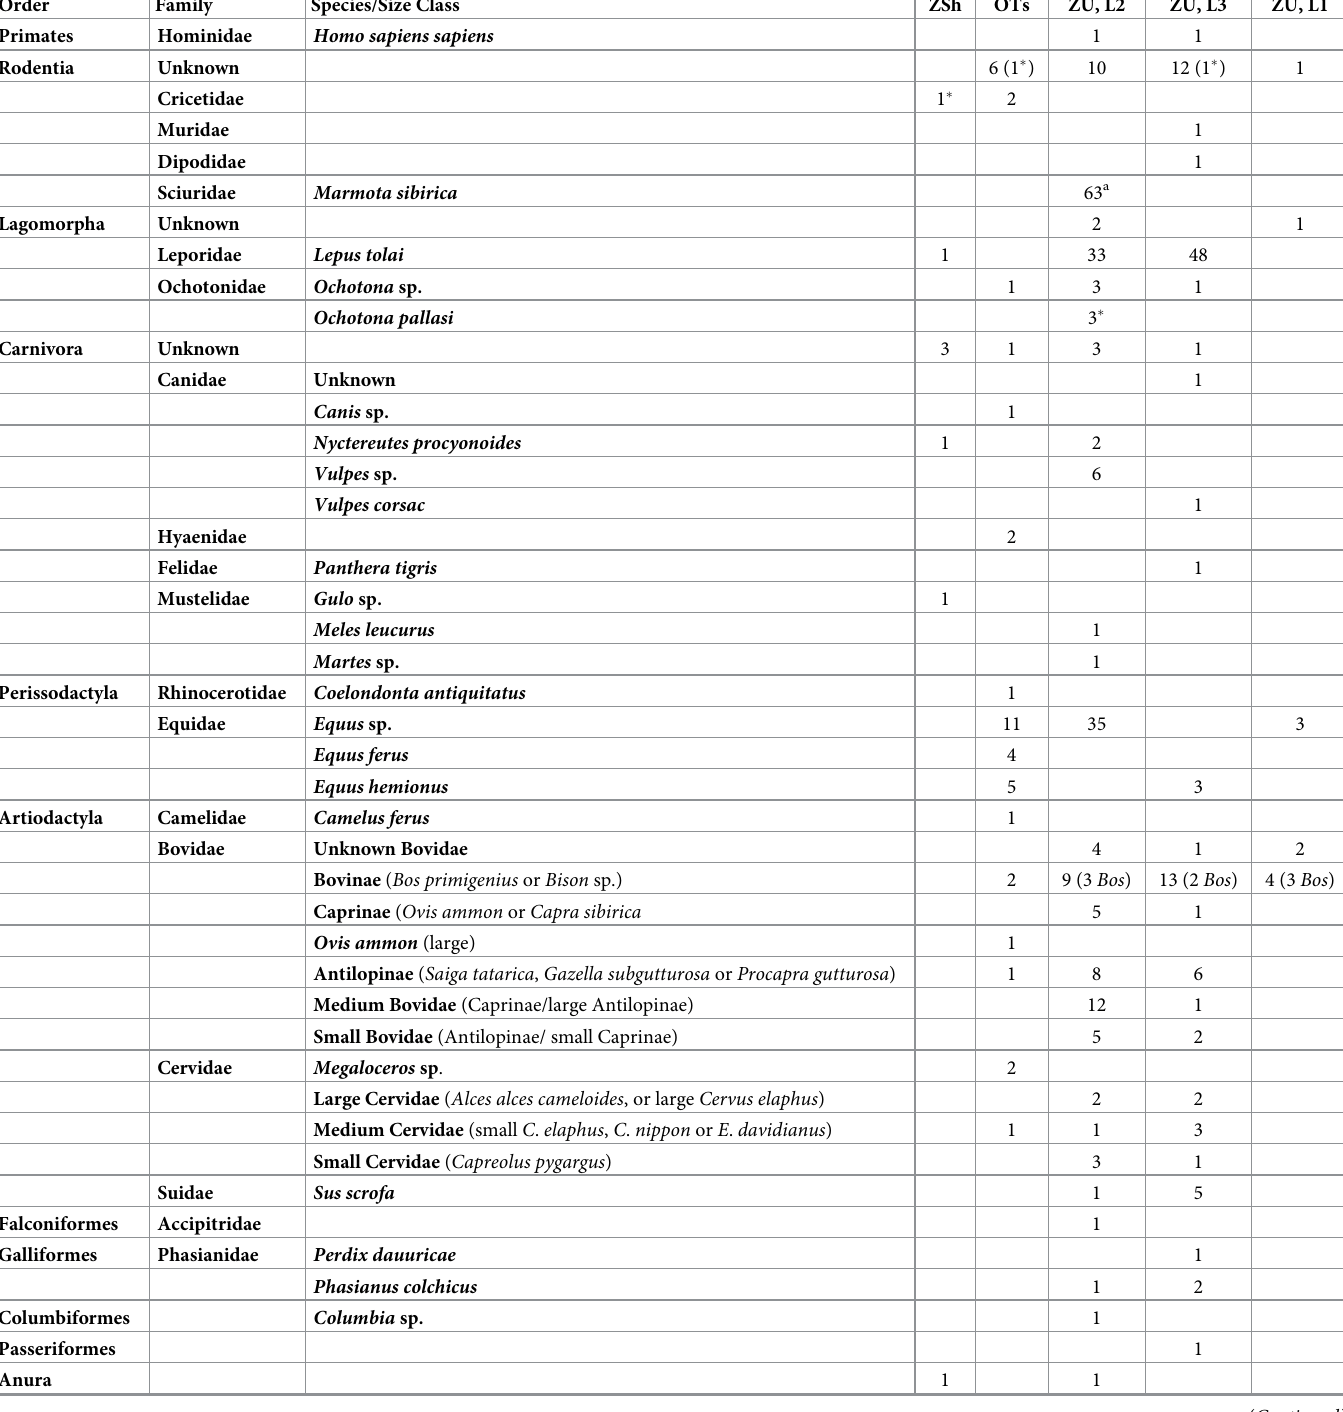
Table 6. NISP distribution of all fauna identifiable to order. Zuun shovkh (ZSh) and Otson Tsokhio (OTs) date between 35,000–25,000 cal BP. ZU Locus 2 (ZU2.T2/3) dates at 8500–7500 cal BP. ZU Locus 3 (ZU3.T1) dates at 7500–6500 cal BP. ZU Locus 1 (ZU2.T1) is a mixed deposit with dates spanning 3495–1717 cal BP. Fauna classi- fied only by body size are not